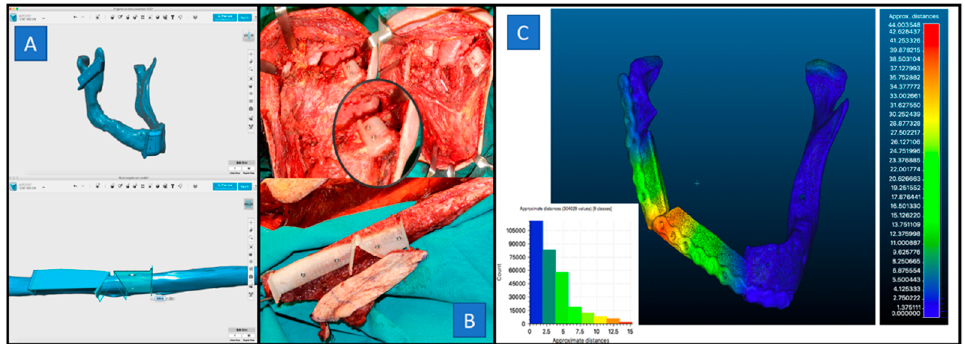
Figure 3. Virtual surgical planning (VSP) of the mandible and fibula cutting-guide ( A ), surgical procedure using the 3D-printed cutting-guides ( B ), and virtual comparison between the surgical planning and post-operative computer tomography (CT) to check the level of accuracy of the VSP ( C